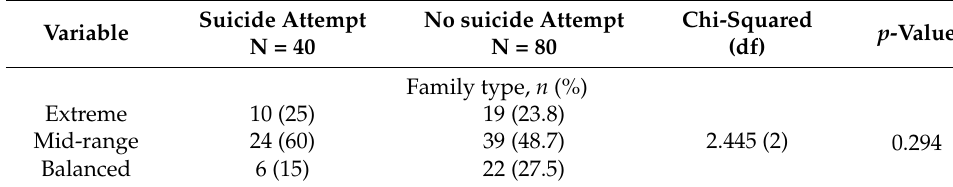
Table 4. Comparison of family types.